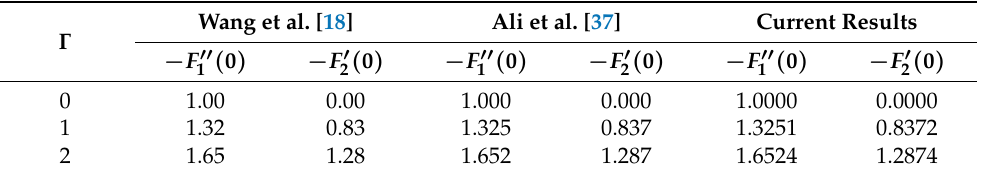
Table 1. Comparison of F (cid:48)(cid:48) involved